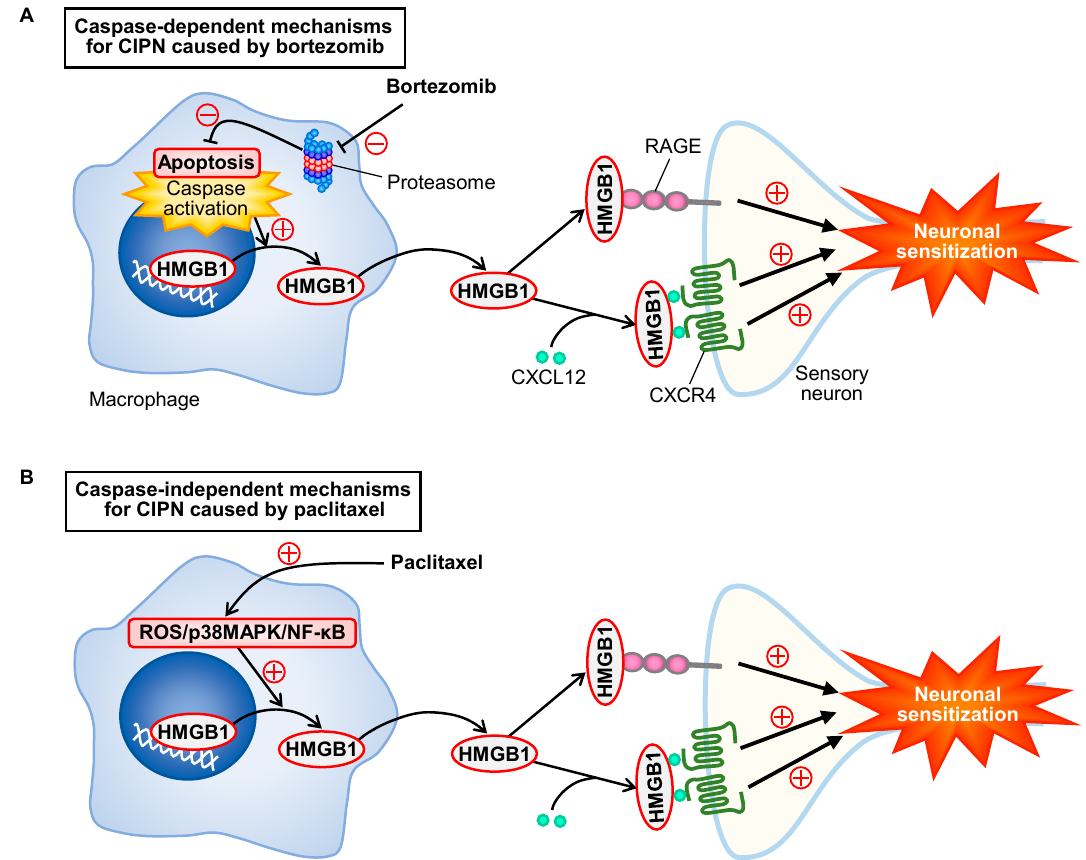
Figure 9. Scheme for bortezomib-induced caspase-dependent HMGB1 release from macrophages and CIPN development, in contrast to caspase-independent mechanisms for paclitaxel. ( A ) Inhibition of proteasome by bortezomib causes caspase- dependent apoptosis of macrophages followed by the release of HMGB1, which in turn causes neuronal sensitization via activation of RAGE and acceleration of CXCL12/CXCR4 signals, leading to CIPN. ( B ) Paclitaxel causes HMGB1 release from macrophages through activation of the ROS/p38MAPK/NF- κ B pathway [5], independently of caspase (see Figure 7D), and the extracellular HMGB1 develops CIPN in a manner dependent on RAGE and CXCR4 [5], as shown in the CIPN caused by bortezomib.